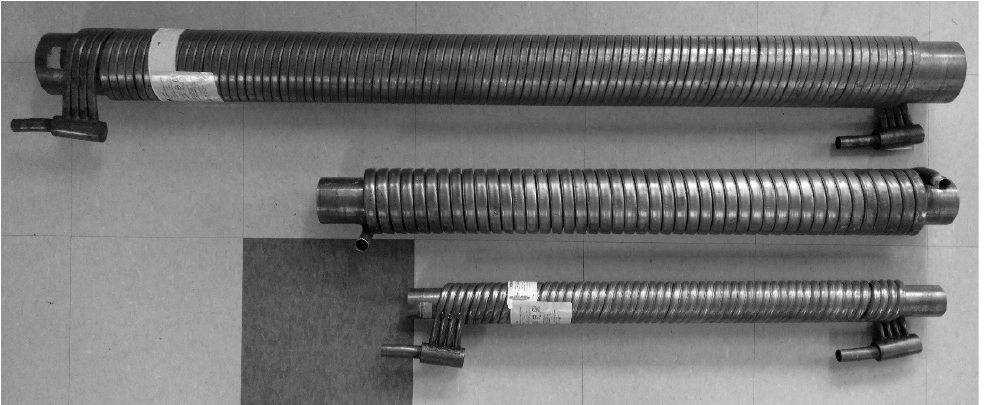
Figure 1. Common designs for falling-film drain water heat recovery (DWHR) heat exchangers.